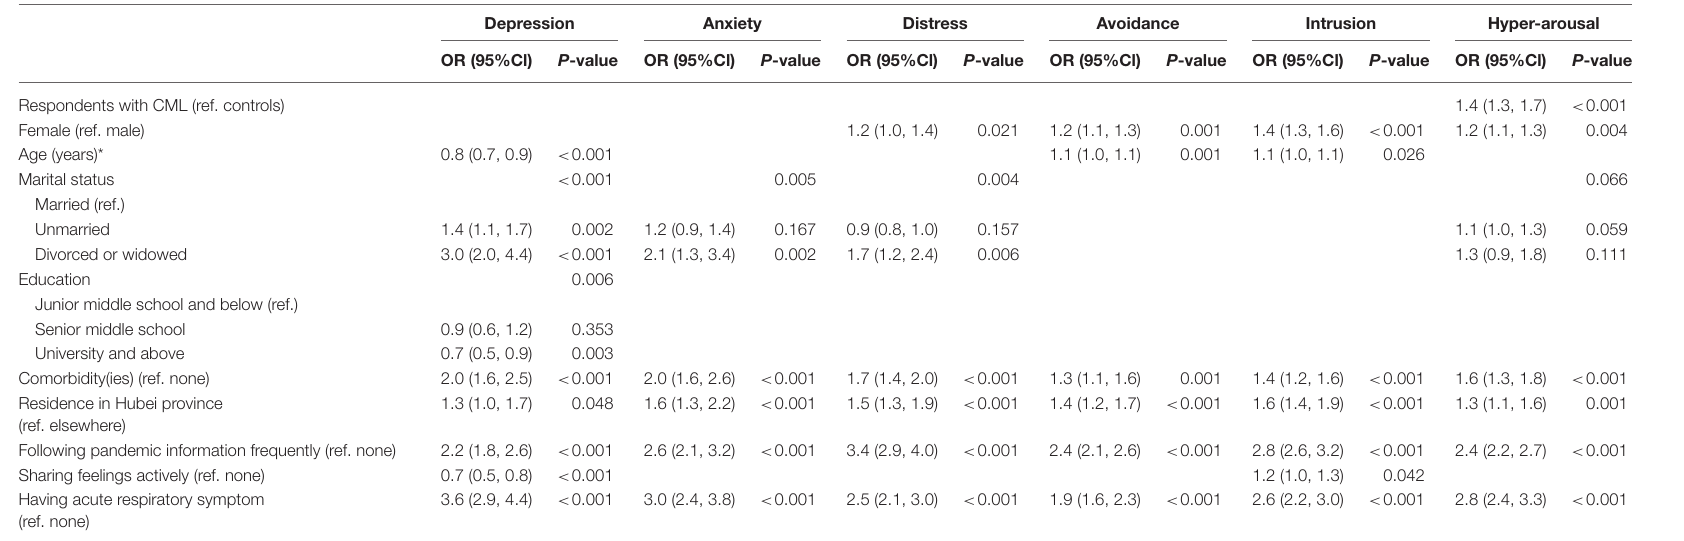
TABLE 6 | Multivariate analyses of mental health of respondents of low-risk group with CML and controls. Depression Anxiety Distress Avoidance Intrusion Hyper-arousal OR